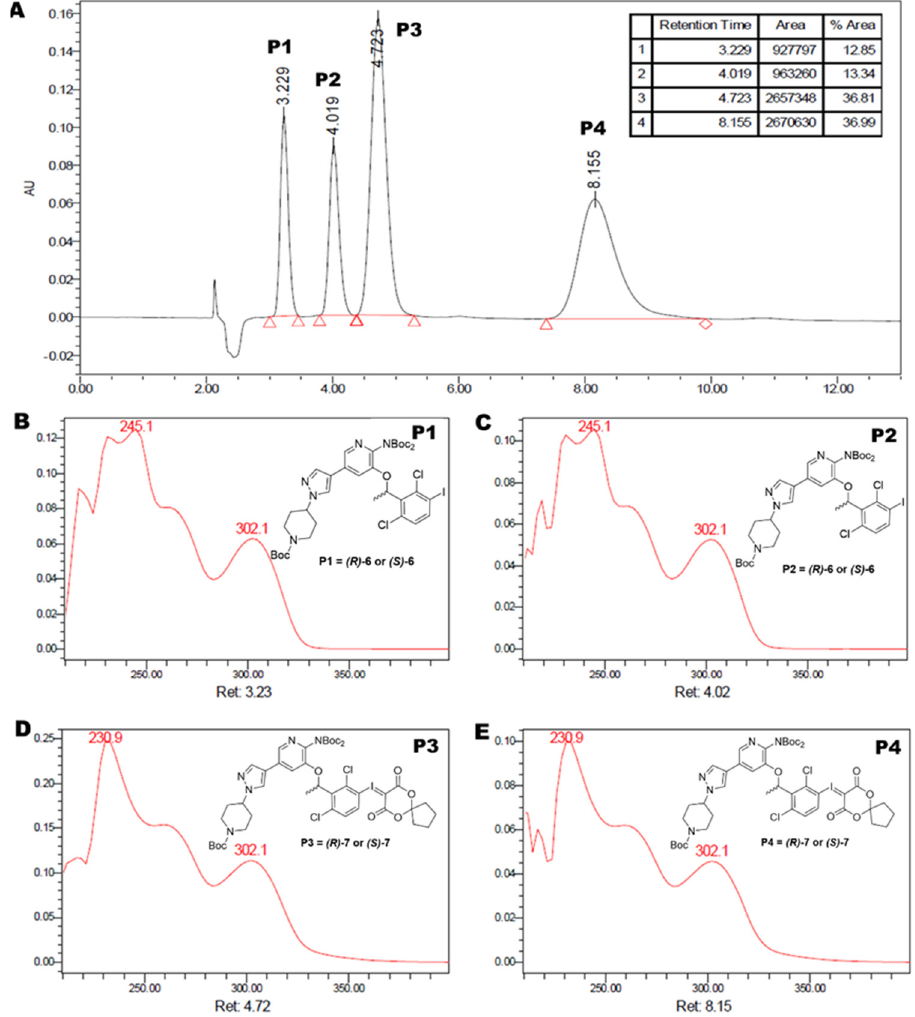
Figure 1. Chiral normal phase HPLC separation of 7. ( A ) Analytical HPLC chromatogram of 7 displaying four compounds P1 to P4. Chromatographic conditions: CelluCoat ® (150 mm × 4.6 mm, 3µm) column with a mixture of heptane/ethanol/trimethylamine (80/20/0.1 v/v/v ) as eluent at a flowrate of 0.8 mL/min and UV detection 260 nm; ( B ) UV trace of the first eluted peak P1; ( C ) UV trace of the second eluted peak P2; ( D ) UV trace of the third eluted peak P3; ( E ) UV trace of the fourth eluted peak P4.